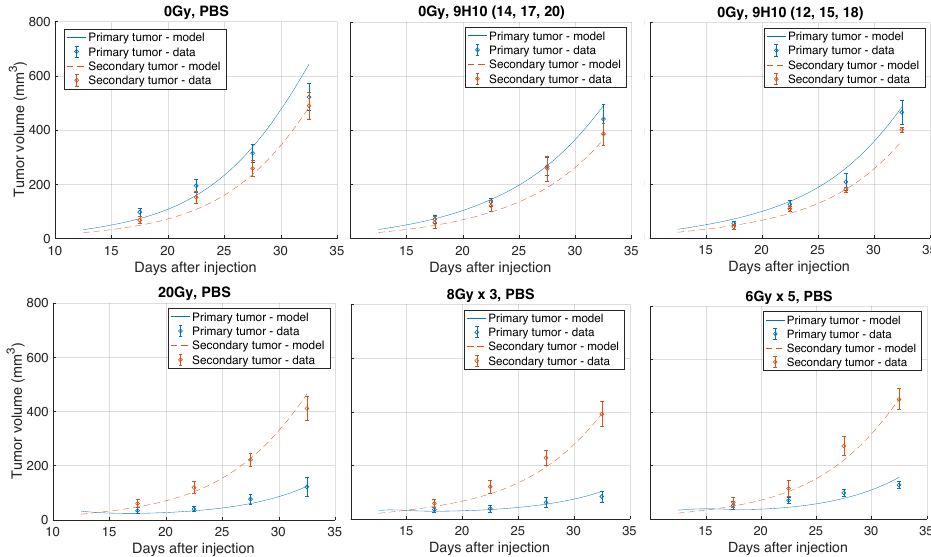
Figure A1. Comparison of model simulated growth dynamics with experimental data. Solutions to the proposed model (lines; Equations (3)–(10)) were obtained after performing data fitting (estimated parameters are presented in Table 1). Shown are experimental and simulated tumor volumes for tumors grown without treatment or after monotherapy. Experimental data (circles) derived from Dewan et al. [11].